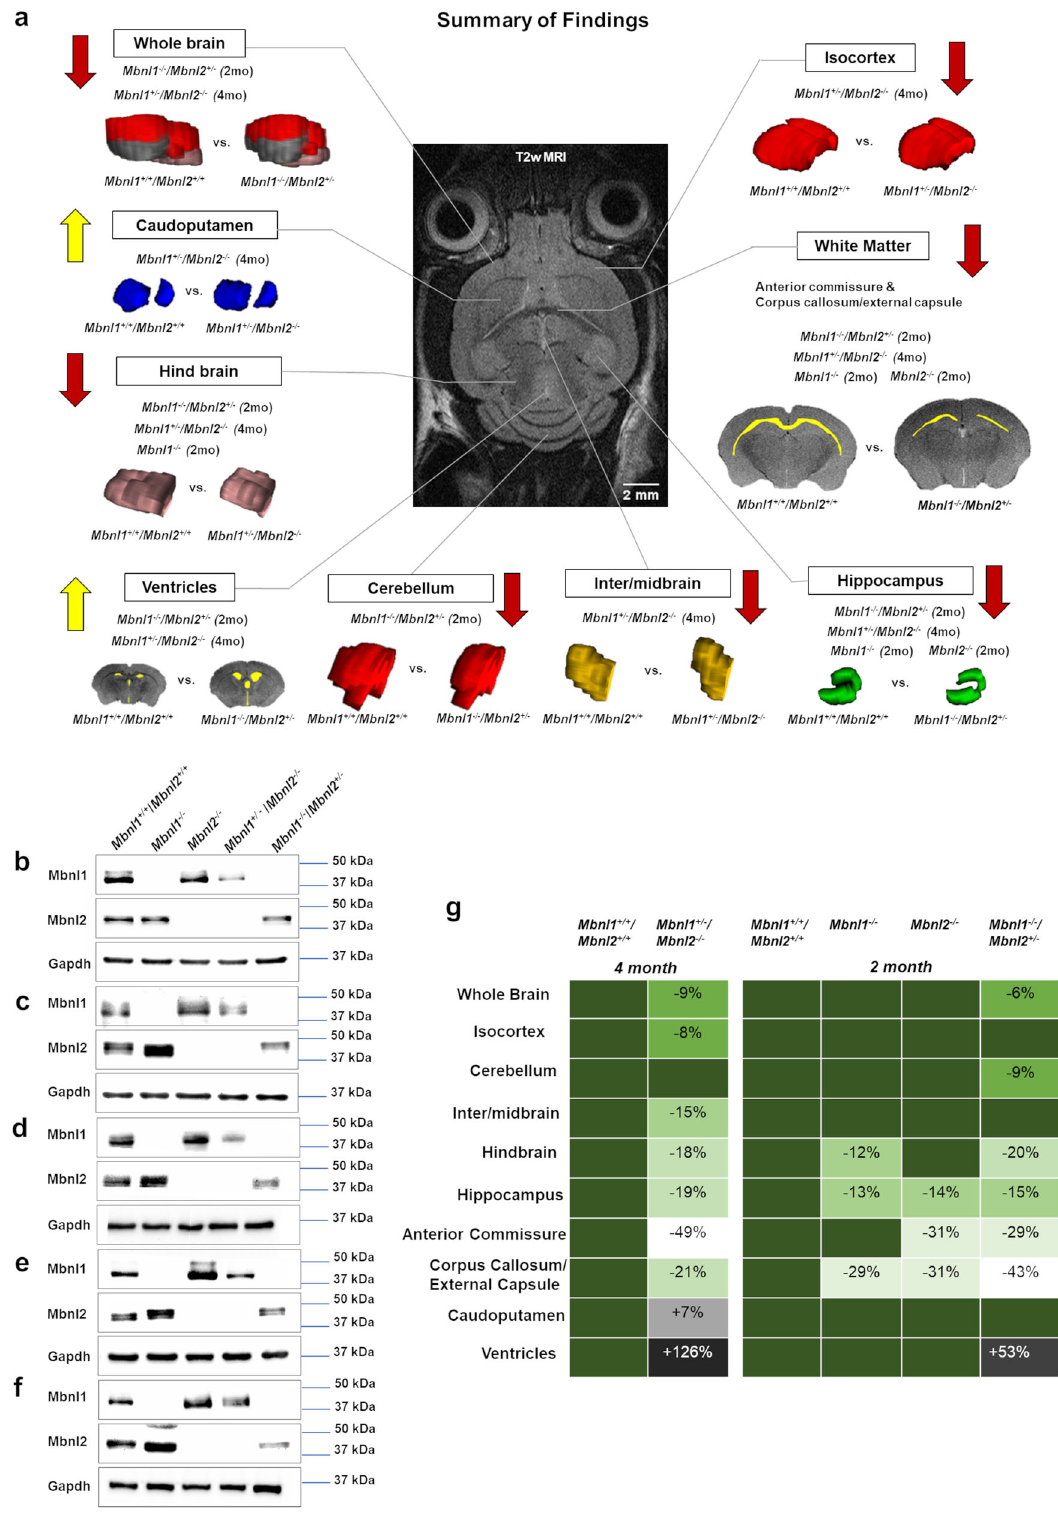
Fig. 8 Summary. a Region-speci fi c alterations in Mbnl1 and Mbnl2 de fi cient mice are shown. b – f Mbnl1- and Mbnl2- levels measured by western blot analyses in the cortex ( b ), hippocampus ( c ), cerebellum ( d ), mid- and hindbrain ( e ), and all other brain regions, including the interbrain and the caudoputamen ( f ), are shown. Gapdh was used as an internal control. g Mbnl1/2 genotype-speci fi c effects on brain regional volume alterations are shown. Increasingly severe volume decreases are indicated in paler- green shades and volume increases are indicated in darker-gray and black